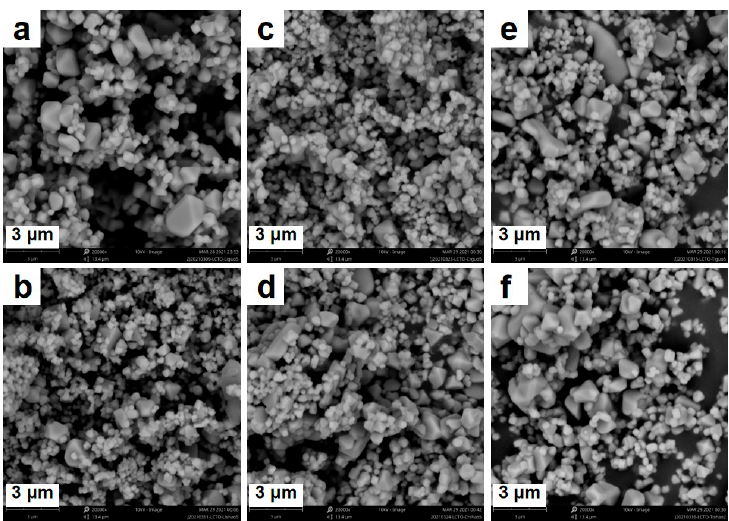
Figure 4. The SEM images of LiCrTiO 4 sintered in a powder form at a temperature of 850 ◦ C with